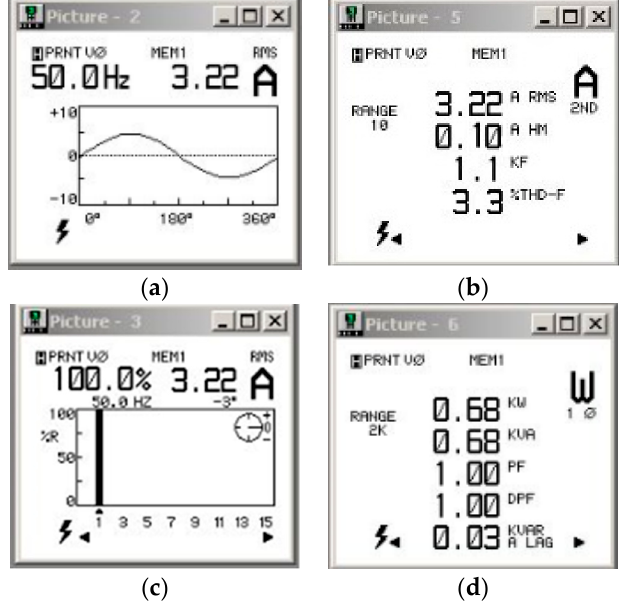
Figure 27. Experimental results for the non-adaptive control at reduced load on the supply side after compensation, in steady state regime, provided by Fluke 41B analyzer: ( a ) waveform of the supply current; ( b ) RMS value and supply current THD ; ( c ) harmonic spectrum of the supply current; ( d ) powers per phase and power factor. Table 7. The main experimental energetic performances of the non-adaptive control, at reduced load.